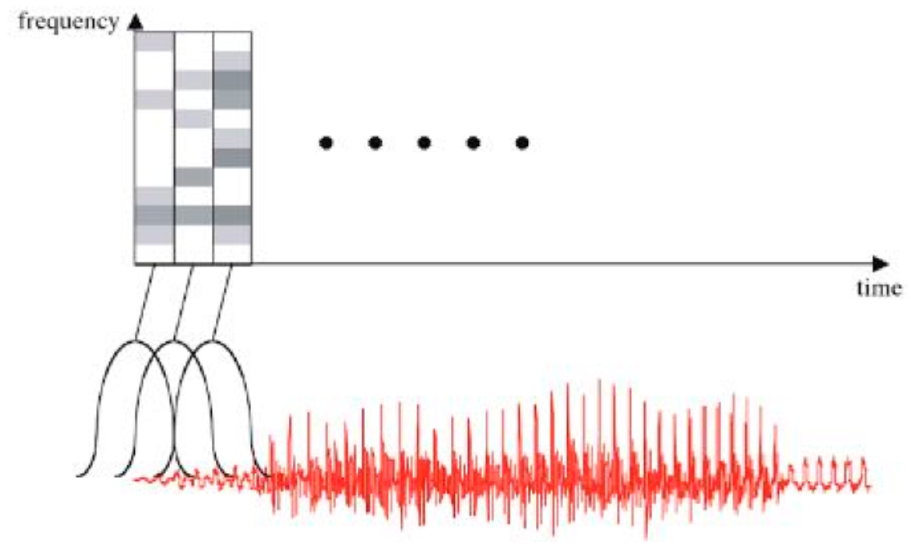
Figure 5. Spectrogram generation from time-domain signal